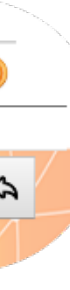
Figure 5. SAVE sensor adapter Wi-Fi setup application.